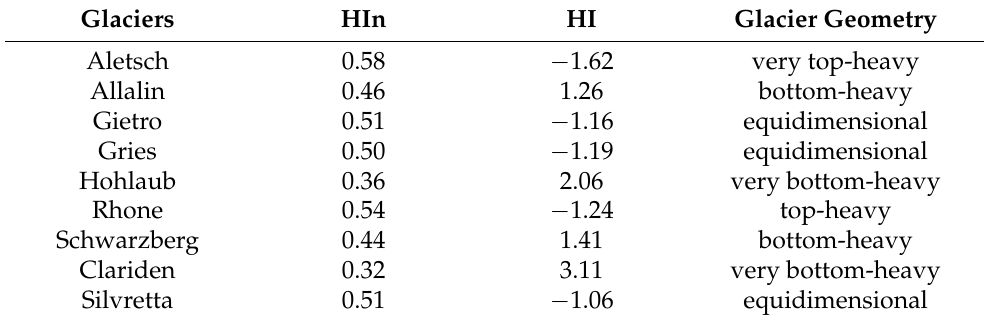
Table 9. HIn, HI and glacier